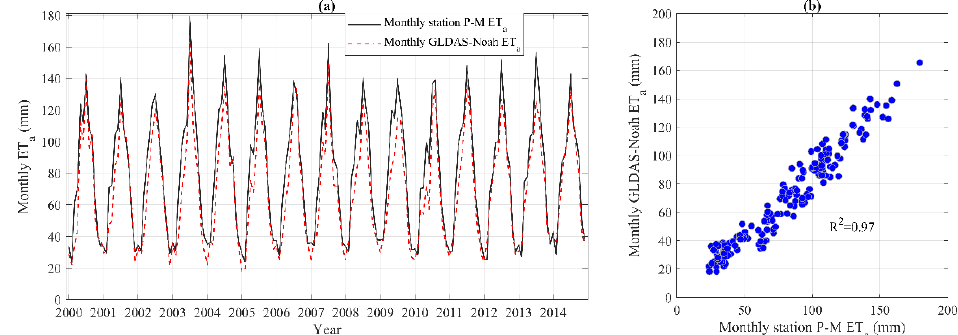
Figure 3 . The compared analysis of monthly ET a between average of egiht stations P-M results and GLDAS-Noah data over MRB in 2000–2019 as ( a ) time series and ( b ) as a scatter plot.